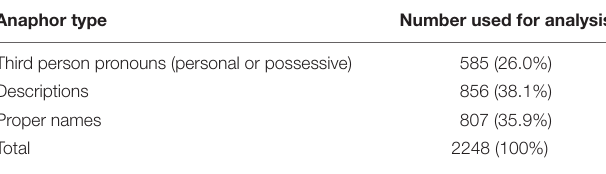
TABLE 3 | Anaphor types.